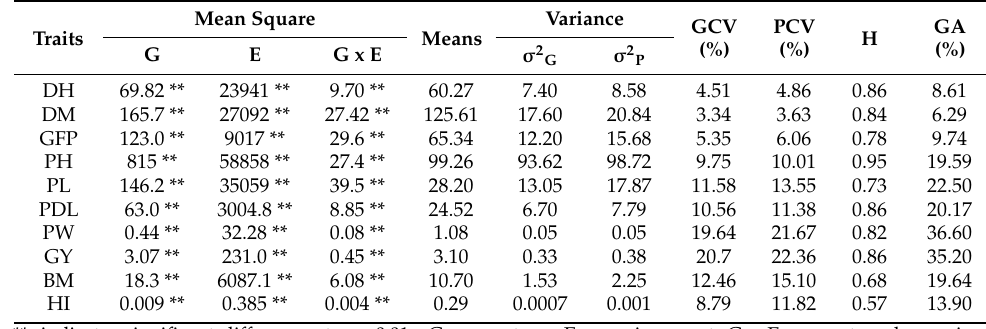
Table 4. Mean squares, variance components, and estimates of variability for important traits of 320 teff genotypes under field growing condition with conventional management (combined over